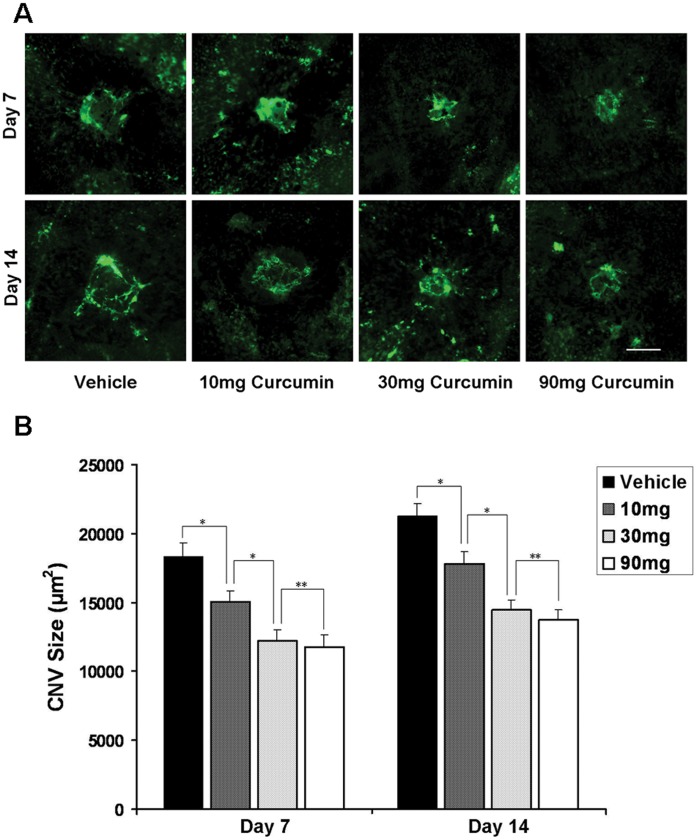
Effects of curcumin on CNV formation.(A) Representative micrographs of CNV lesions in the RPE–choroid flat mounts from vehicle-treated mice and curcumin-treated mice on day 7 and day 14 after laser photocoagulation. CNV is indicated by green fluorescence and FITC-dextran angiography. Scale bar = 100 µm. (B) Quantitative analysis of CNV size in RPE–choroid flat mounts. Day 7: Vehicle, n = 42 spots; 10 mg/kg curcumine, n = 45 spots; 30 mg/kg curcumine, n = 42 spots; 90 mg/kg curcumine, n = 39 spots. Day 14: Vehicle, n = 66 spots; 10 mg/kg curcumine, n = 54 spots; 30 mg/kg curcumine, n = 60 spots; 90 mg/kg curcumine, n = 63 spots. *P<0.05; **P>0.05.